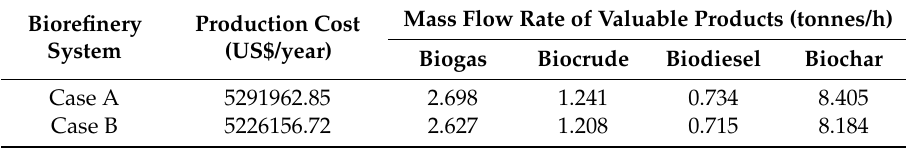
Table 7. Mass flow rate of useful products from the proposed biorefinery system.